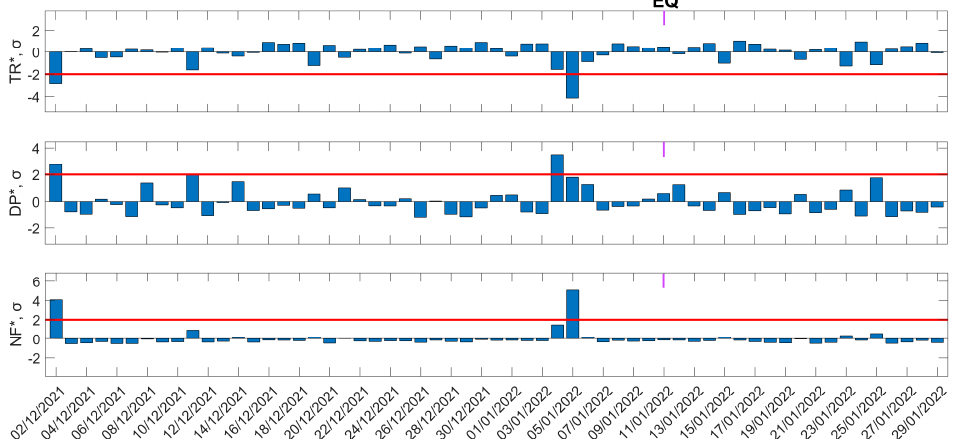
Figure 4. Time evolution of three statistical quantities, TR * , DP * , and NF * , of the NFM analysis method for the sub − ionospheric path GER − ISR is shown in the top, middle, and bottom panels, respectively. The time period represented in the figure is from 2 December 2021 to 29 January 2022. Red solid horizontal lines indicate the corresponding +2 σ / − 2 σ limits; σ is calculated for the whole studied period of each panel. The date of EQ is shown on top of each panel by the purple vertical line segment, marked on the top of each panel. Table 2. Results of NFM for the 2022 Cyprus EQ. UWA, GER, and ACH denote the station where the corresponding anomaly in 𝑇𝑅 ∗ , 𝐷𝑃 ∗ , or 𝑁𝐹 ∗ has been identi fi ed.